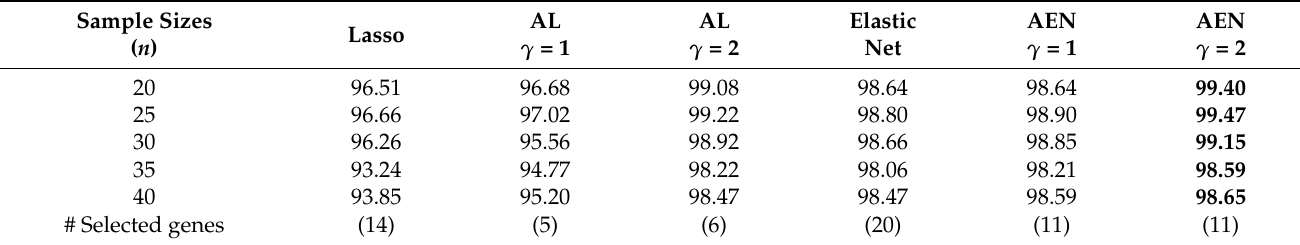
Table 10. The average percentage of accuracy and the average number of selected genes of lasso, adaptive lasso (AL), elastic net, and adaptive elastic net (AEN) under 50 leukemia